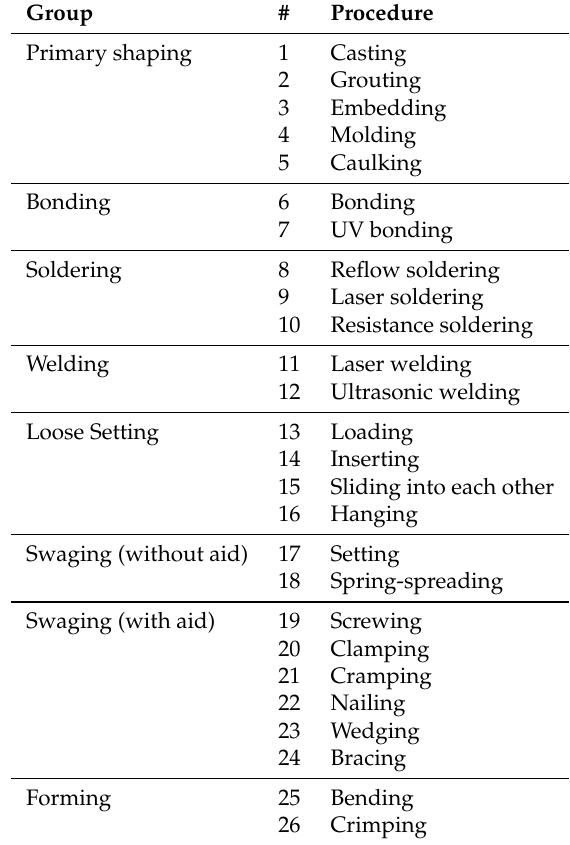
Figure 5. Overview of the new found procedure type grouping for micro-assembly. For each group, one example is given. Table 4. The 26 procedure types and their corresponding